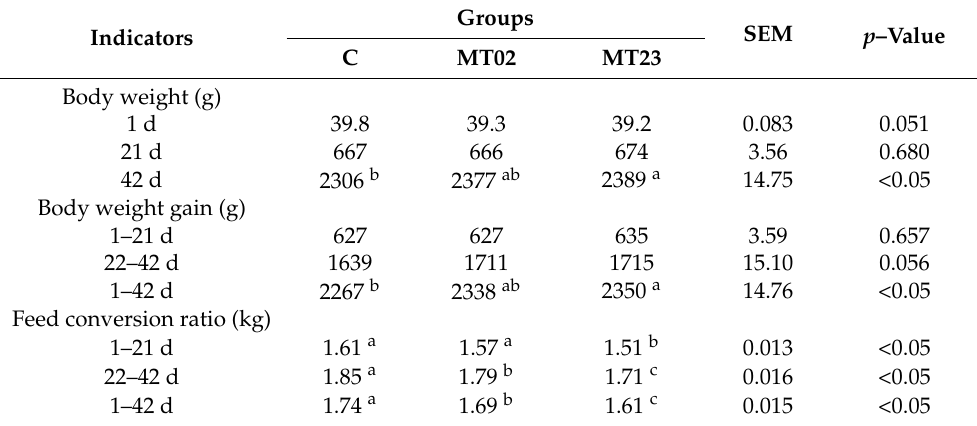
Table 3. Rearing results of broiler chickens.